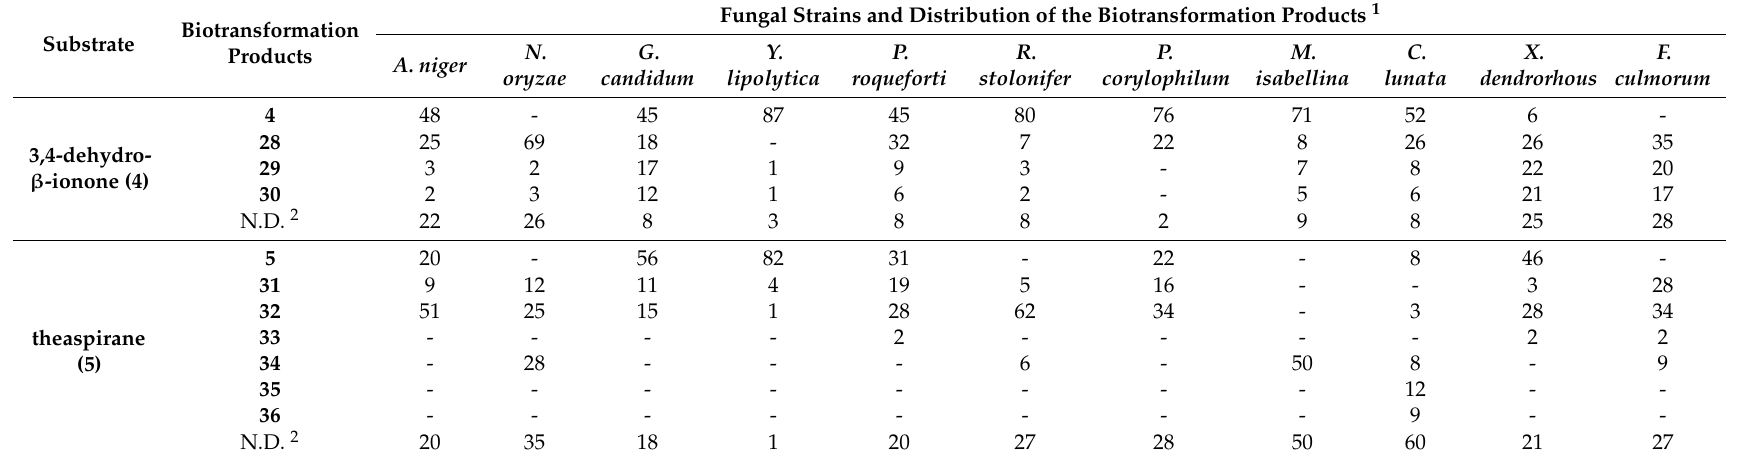
Table 2. Results of the fungi-mediated biotransformation of 3,4-dehydro- β -ionone and